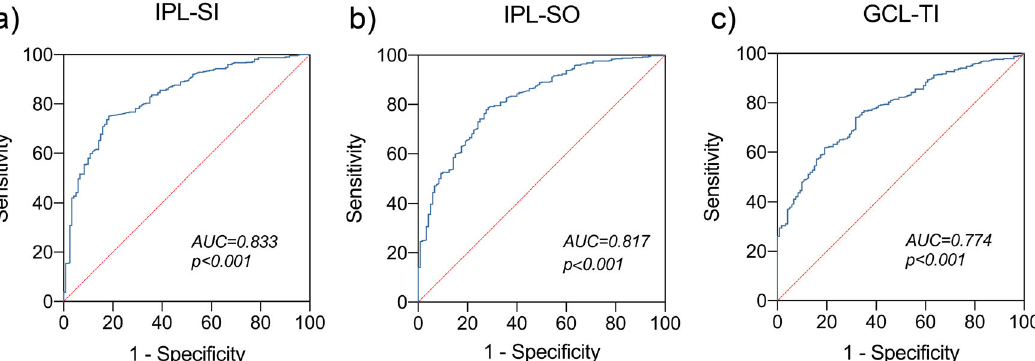
Fig. 4 Receiver operating characteristic (ROC) curve for the retinal parameters. Results showed that IPL thickness in the SI sub fi eld (IPL-SI) showed the best diagnostic performance, followed by IPL thickness in the SO sub fi eld (IPL-SO) and GCL thickness in the TI sub fi eld (GCL-TI). IPL inner plexiform layer, GCL ganglion cell layer, SI superior inner, SO superior outer, TI temporal